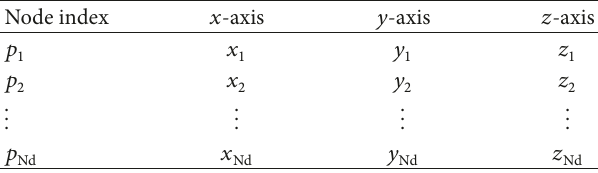
Table 2: The spatial location information of the sampling